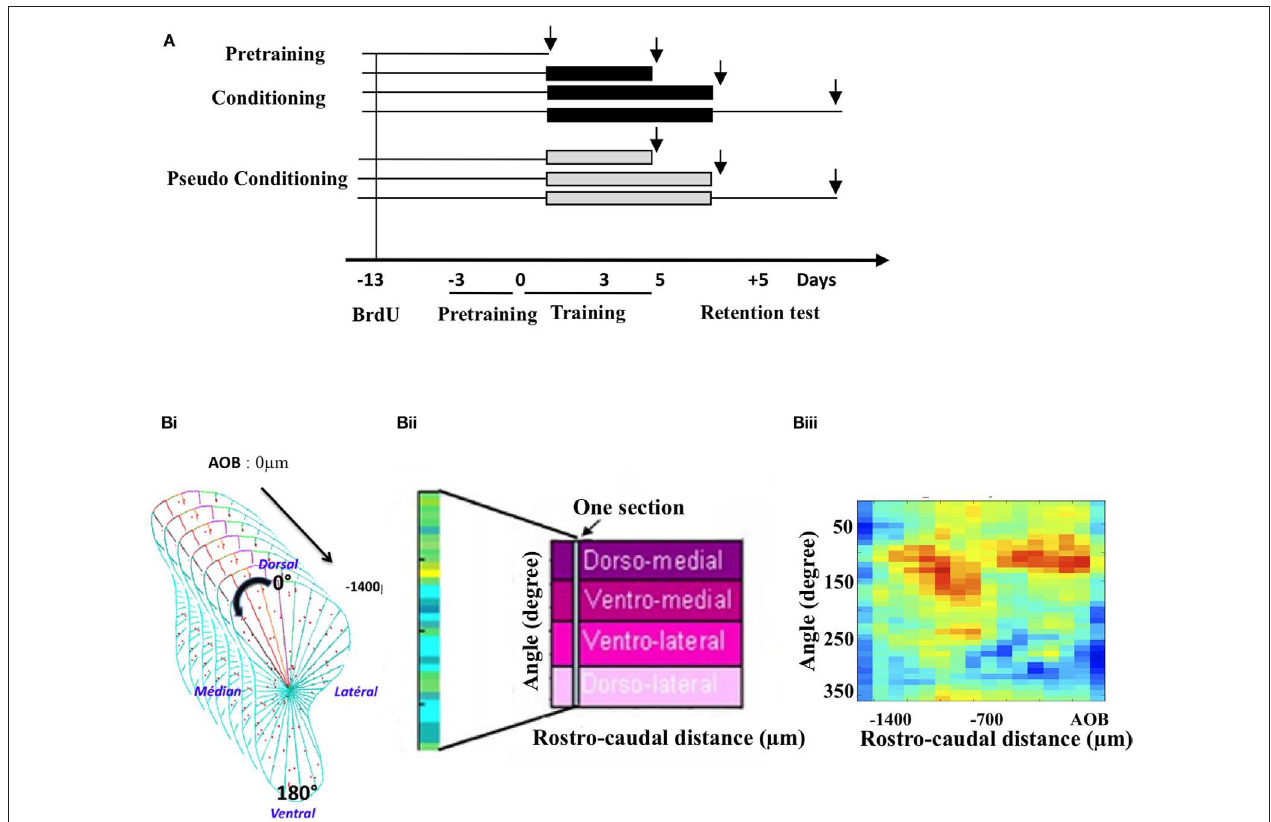
were processed for BrdU or activated-caspase3 immunohistochemistry and every labeled cell was then counted on each section. The GCL was divided into 36 sectors of 10 ° and a density of labeled profiles was calculated for each sector (Bi) . The value of cell density obtained was then reported into a matrix in which one column represented all the sectors of one section. Sections were aligned along the rostro-caudal axis (Bii) . Finally, pseudo-color representation of the matrix was generated, giving a 2-dimension image of the density of labeled cells in the GCL. An example of such representation is given (Biii)